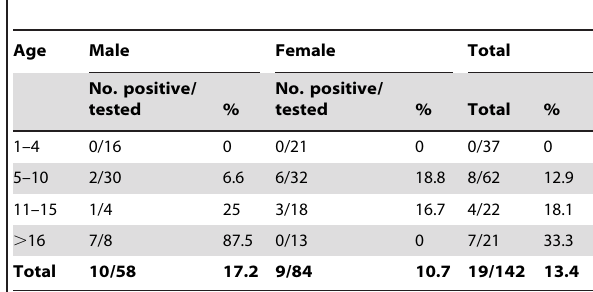
Table 1. Distribution of STLV-1 infection in our semi-free- ranging colony of 142 mandrills by age group and